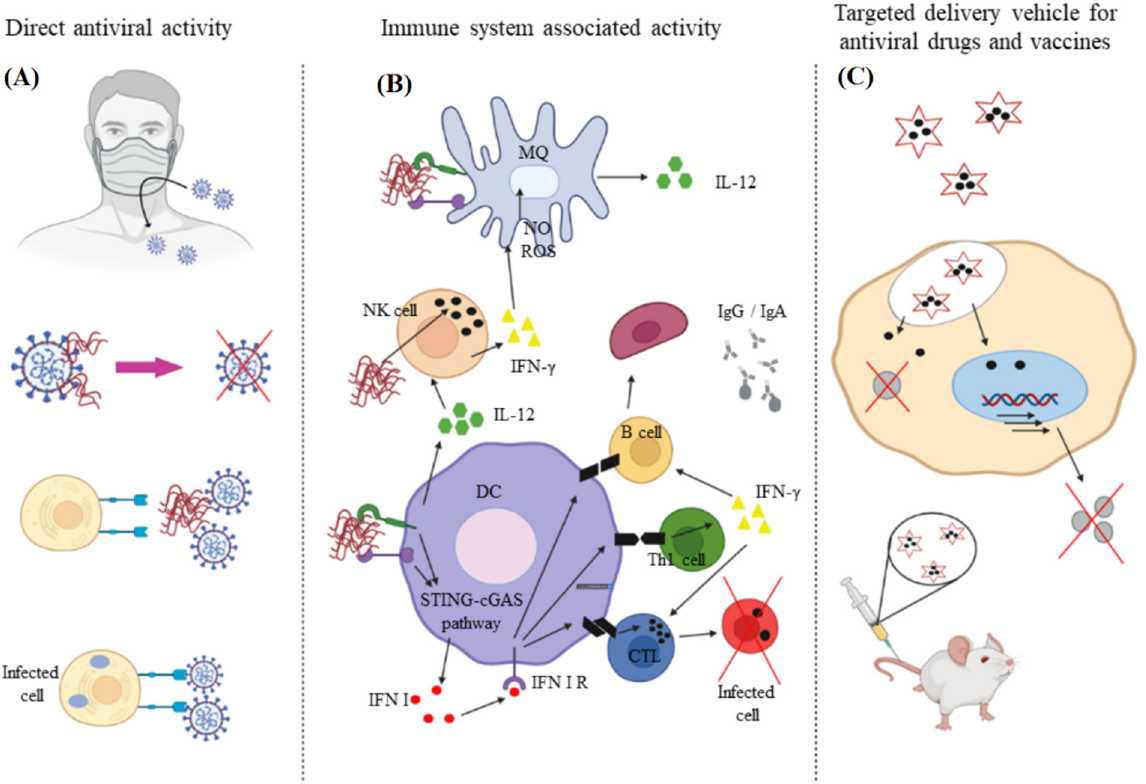
Figure 5. The direct ( A ) and indirect ( B ) approaches to using chitosan to inhibit viral infection; ( C ) chitosan is also used as a carrier for delivery of antiviral agents. Reprinted with permission from Ref. [83]. Copyright 2021, Elsevier.